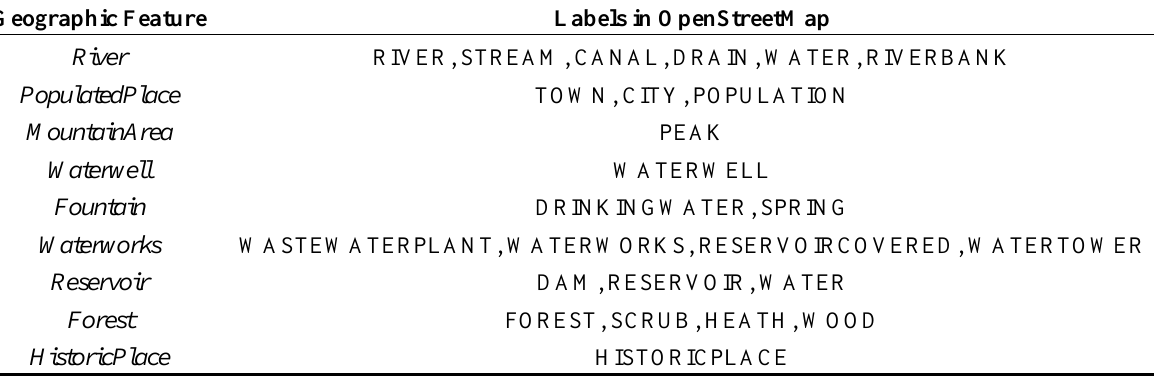
Table 1. Example of labels used in OpenStreetMap to select geographic